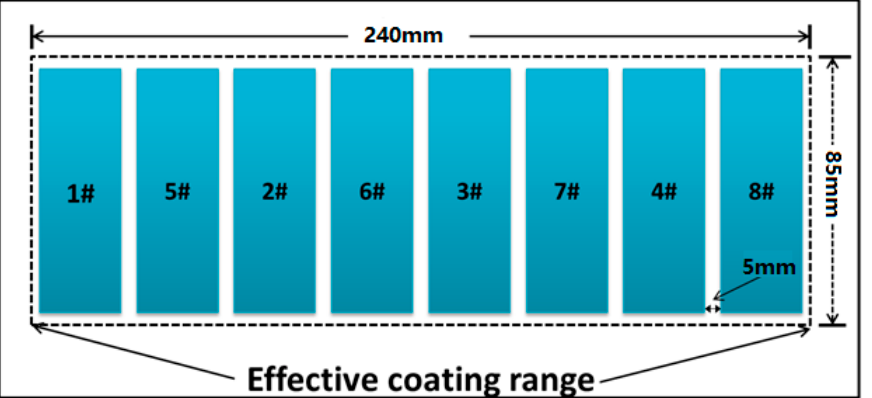
Figure 2. Position distribution of the glass slides on the sample holder.